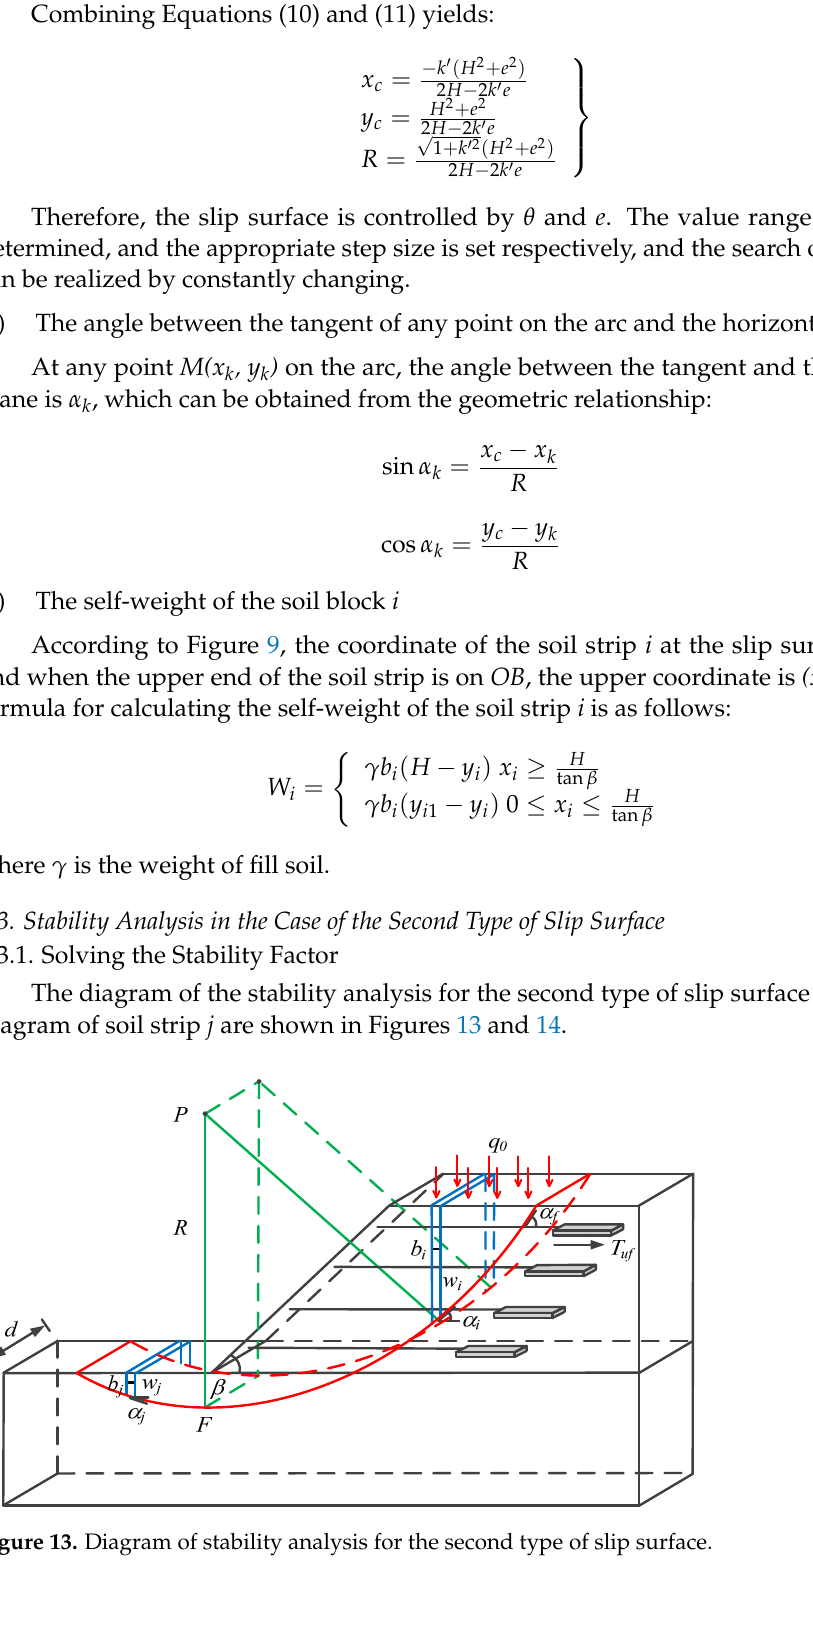
Figure 14. Force diagram of soil strip j. Soil strip on the left side of OF. The force provided by the anchor-plates on the soil strip j is as follows: 1 [ (21) Soil strip on the right side of OF. The force analysis of the soil strip on the right side of OF is similar to that in the case of slip surface 1, and the final deduced results are Equations